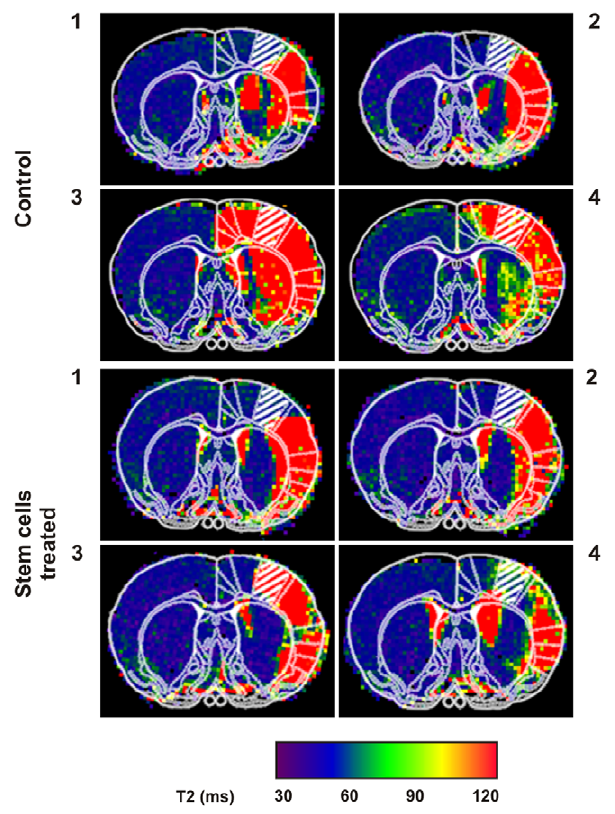
Figure 5. Spread of ischemic lesion. T2 maps of the 4 control (top) and 4 stem cell implanted (bottom) animals used in our study. The corresponding coronal sections of the Paxinos and Watson atlas of the rat brain [12], with the key brain region S1 FL shadowed, have been superimposed in each image, showing that animals labeled as 3 and 4 for each group presented lesions that include this region of the cortex, while in the others (animals 1 and 2 of each group) the S1 FL region is not